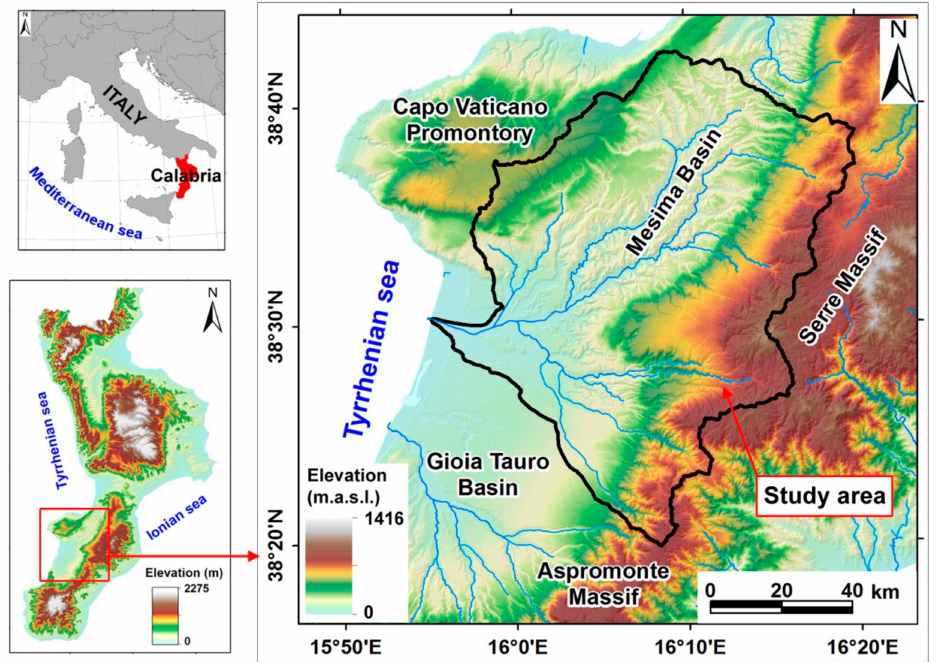
Figure 1. Location of study